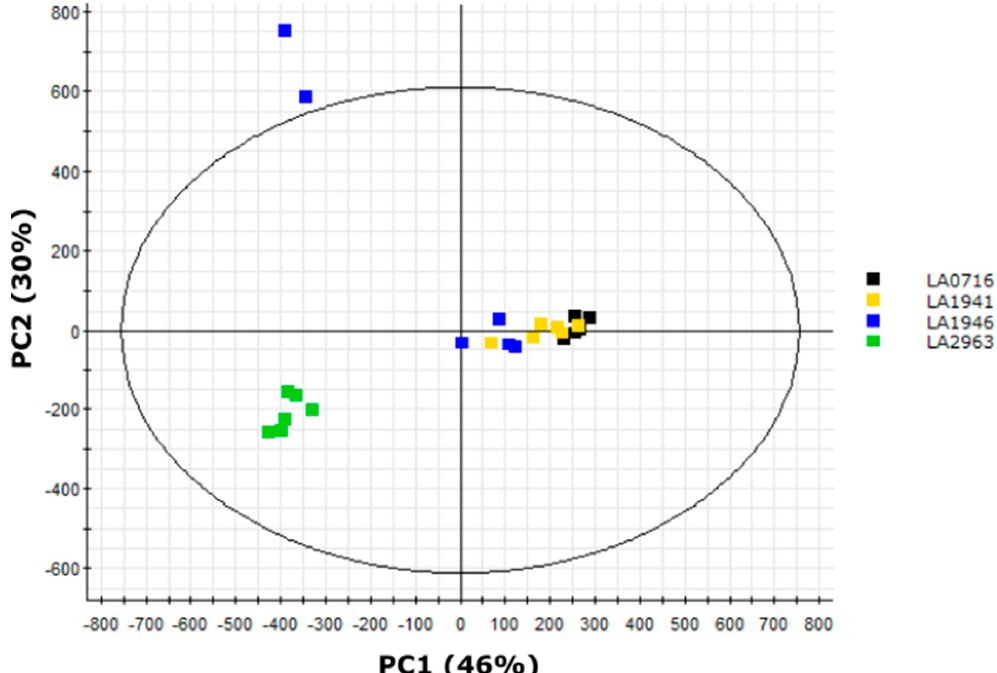
Figure 7. PCA scores plot of samples from four S. pennellii accessions in the Atico region of Peru separated by abundances of 54 metabolite features identified in trichome extracts by UHPLC–HR-MS. Samples from accession LA0716 are indicated in black, samples from accession LA1941 in yellow, samples from accession LA1946 in blue, and samples from accession LA2963 in green (see Figure 2 for details of the Atico region). PC1 accounted for 46% of variance and described most of the variation between accession LA2963 samples and other Atico region accessions, while PC2 accounted for 30% of variance and described primarily variation within the main Atico cluster.